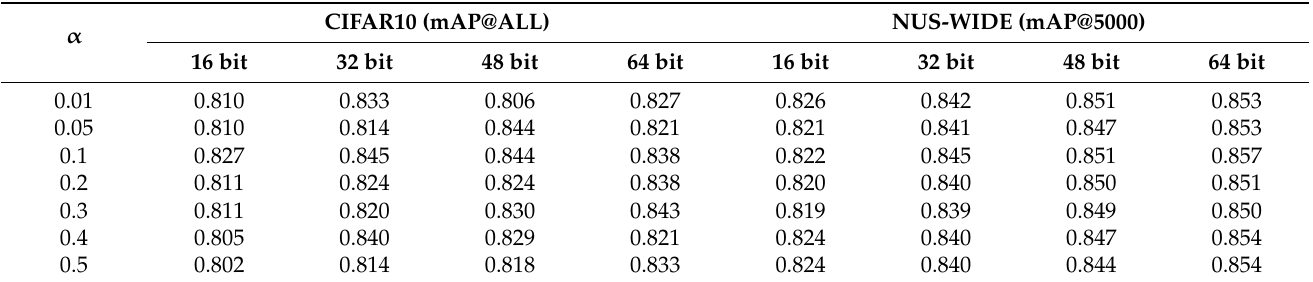
Figure 3. The corresponding mAP value when α takes different values. Table 4. mAP of different α .